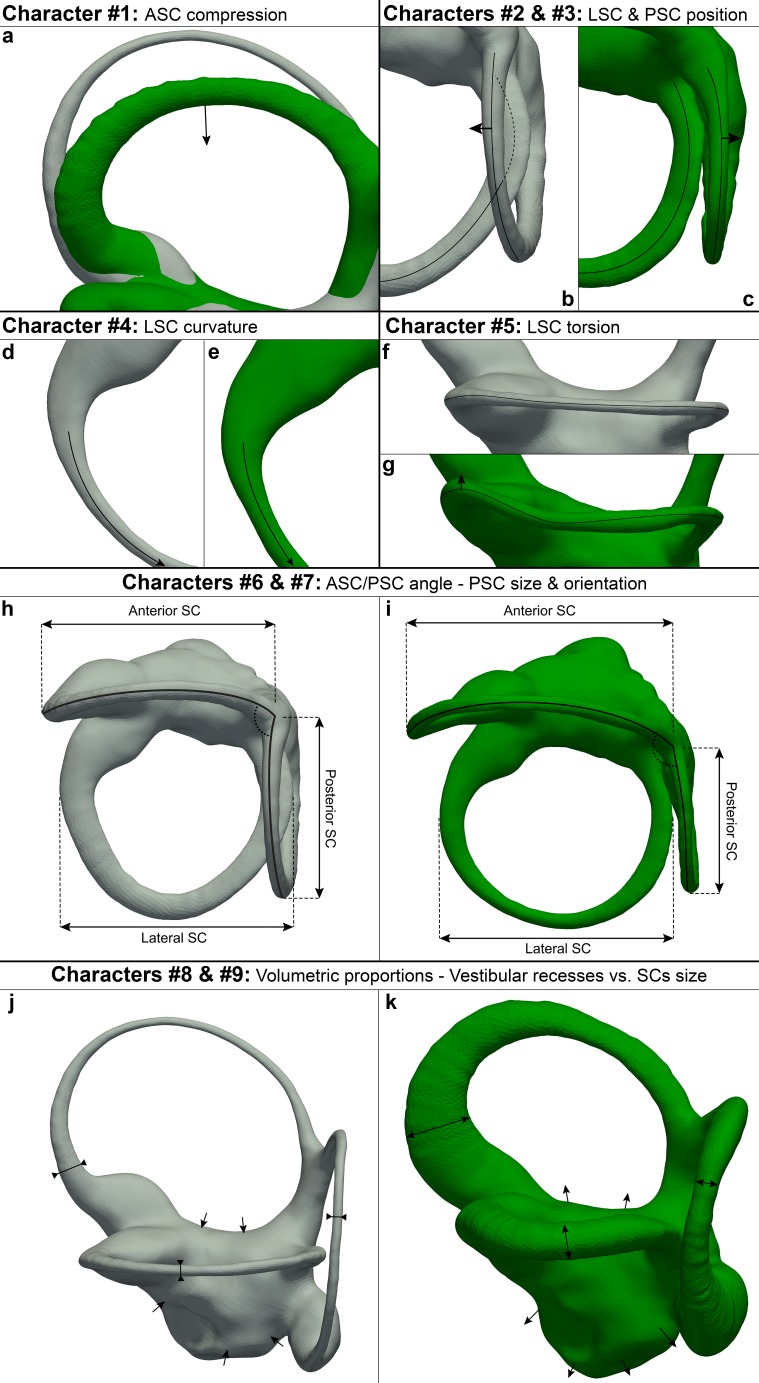
Illustration of hominoid, hominid and hylobatid synapormophies for the vestibular apparatus.See Table 8 for further details. character #1: (a) rounded (gray) and compressed (green) anterior canal; character #2: (b–c) non-posteriorly displaced posterior canal (gray), posteriorly displaced posterior canal (green); character #3: (b–c) lateral canal intersecting(dashed line) the posterior one (gray), lateral canal non-intersecting the posterior one (in green); character #4: (d-e) curved (gray) and straight (green) medial portion of the lateral canal; character #5: (f–g) flat (gray) and bent upwards (green) trajectory of the lateral canal ampullar portion; character #6: (h–i) anterior and posterior SCs forming an angle (dotted arc) close to the right angle (gray), anterior and posterior canals forming an obtuse angle (green); character #7: (h–i) posterior canal equal in size to the other SCs and forming a right angle with the lateral canal (gray), small posterior canal relative the other SCs and inclined posteriorly respective to the lateral canal (green); character #8: (j–k) slender SCs (gray), stout canals (green); character #9: (j–k) small vestibular recesses (gray), enlarged vestibular recesses (green).